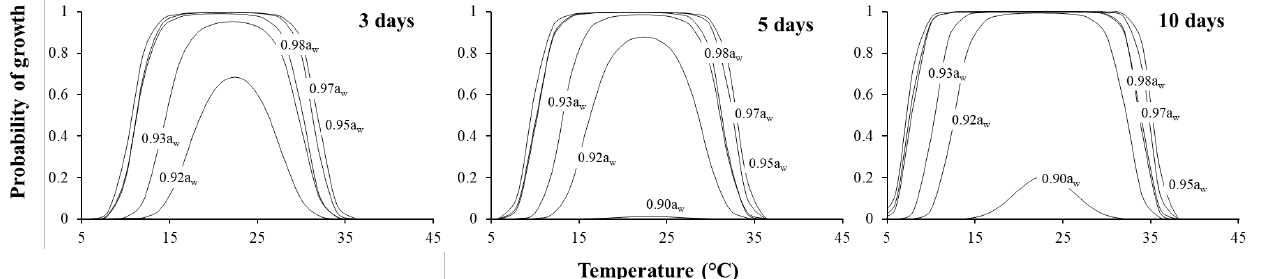
Figure 4. Estimated probability of growth of F. asiaticum (strain 082) under different interacting environmental conditions on a wheat-based media after 3, 5 and 10 days.